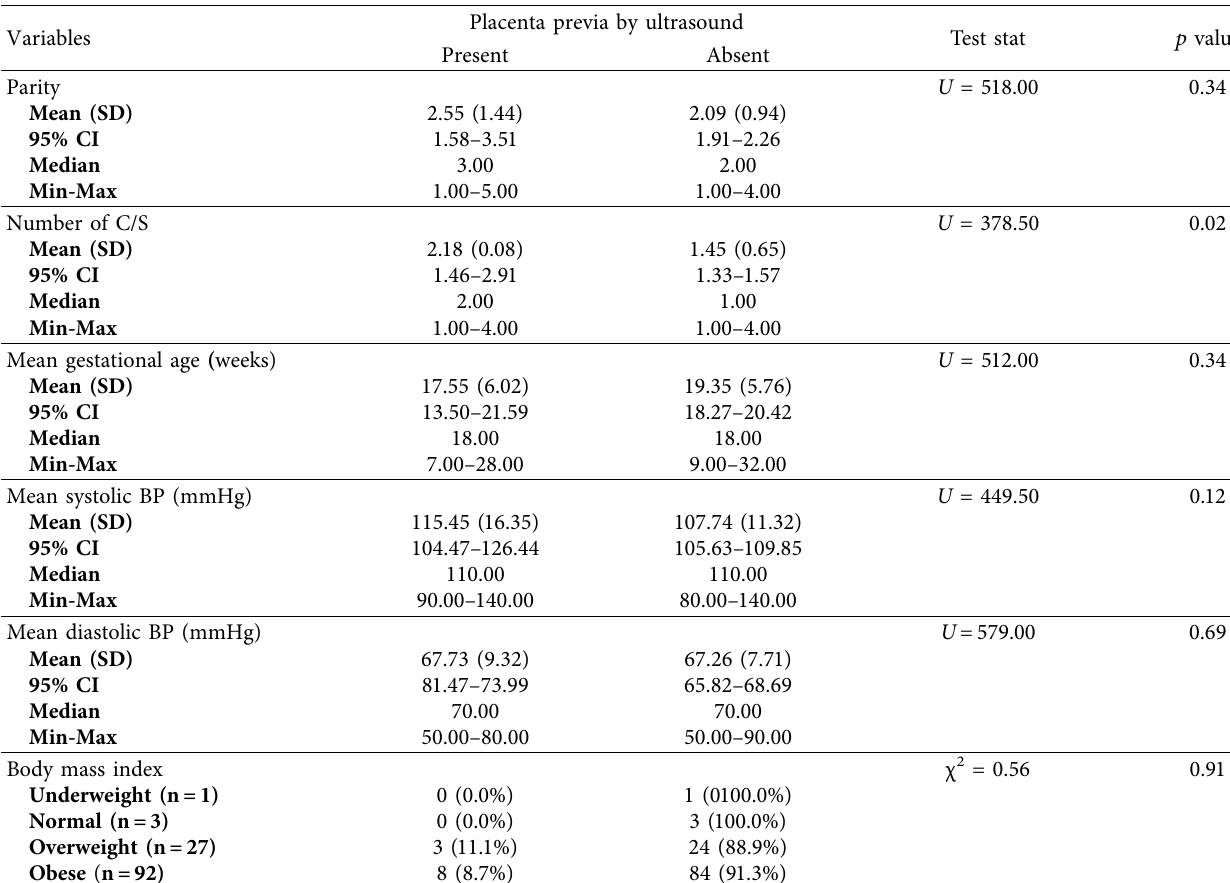
Table 5: The association between clinical factors and the presence of placenta previa using ultrasound among women with a short interpregnancy interval ( n �